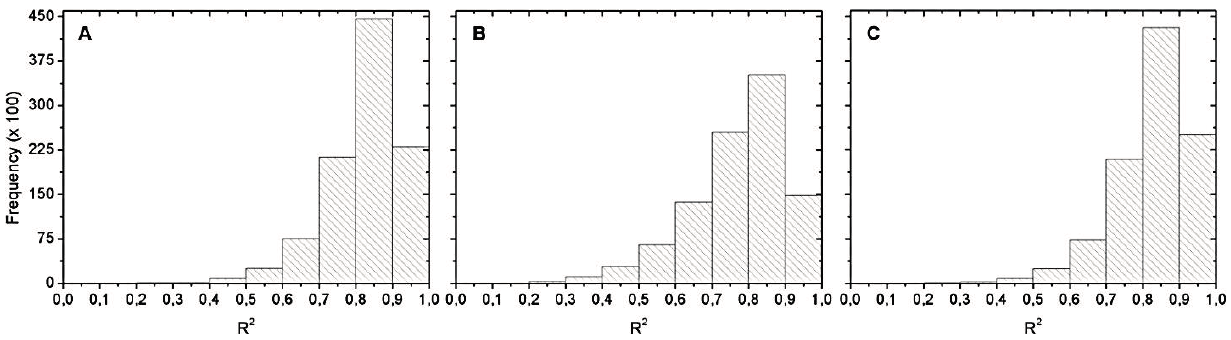
Figure 10. Histograms of the R 2 distribution for: ( A ) May 2012; ( B ) September 2012; and ( C ) April 2013. OLCI simulated data with no chl- a below 20 µg·L − 1 .